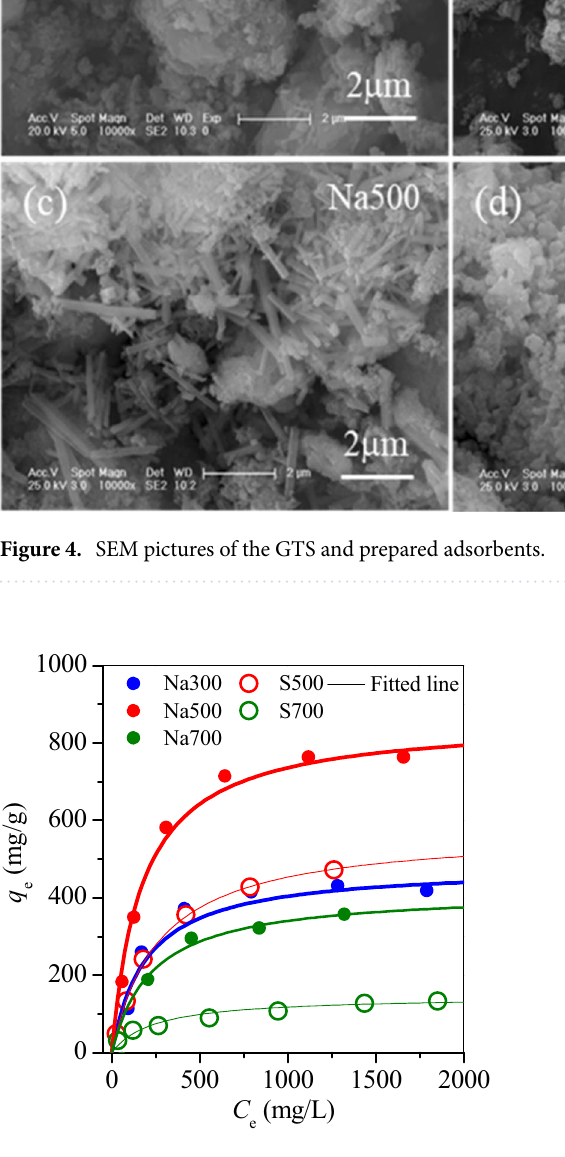
Figure 5. Linear fitting of oxytetracycline adsorption on the prepared magnetic adsorbents.